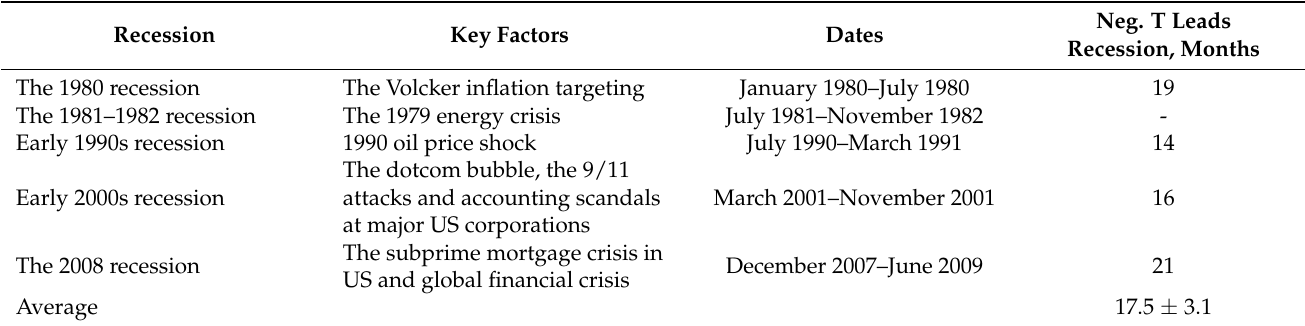
Table 1. Recessions in the USA, 1970 to 2019.